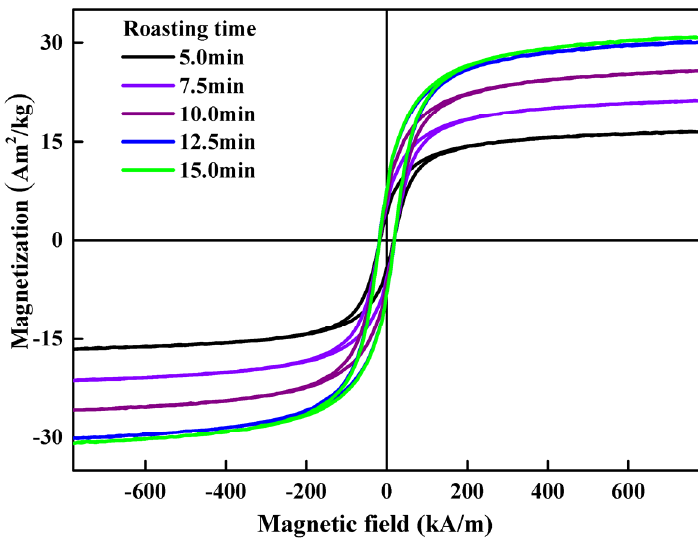
Figure 9. Hysteresis loops of roasted products.